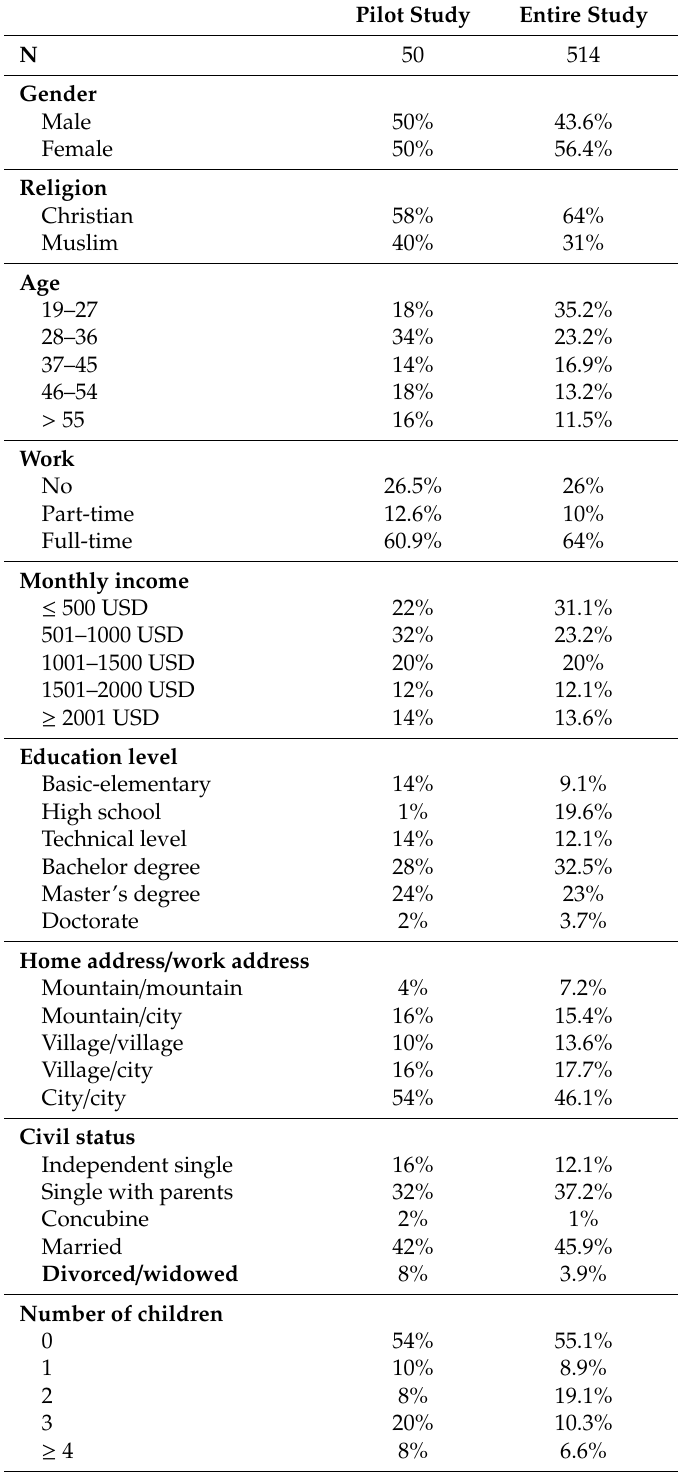
Table 1. Demographic data of the pilot study (N = 50) and the entire survey (N =